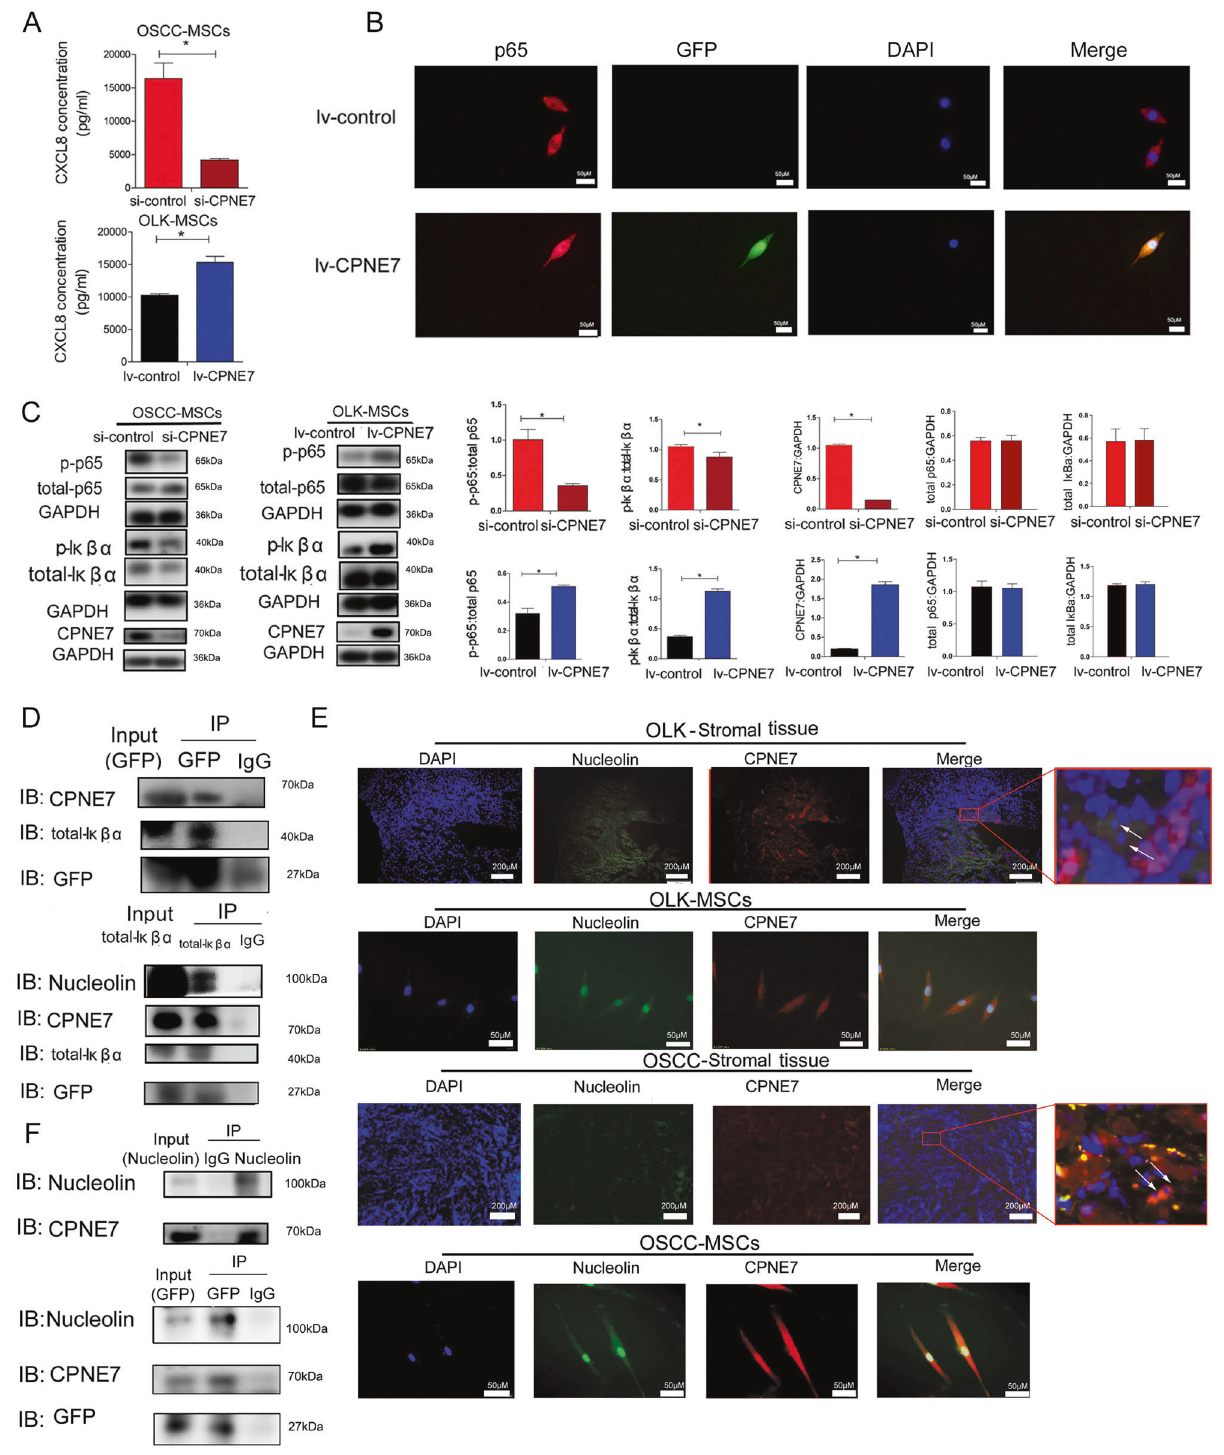
Fig. 6 CPNE7 could enhance the secretion of CXCL8 and interact with I κ ß α through the NF- κ B pathway. A Overexpression and knockdown of CPNE7 in MSCs regulated CXCL8 secretion. B Immuno fl uorescence on overexpression of CPNE7 (GFP-tagged CPNE7) in OSCC-MSCs was performed to detect the localization of p65 (red) and GFP (green) were stained with DAPI (blue). C Western blot was used to measure the difference in the expression of p65 and I κ B α (NF- κ B pathway) in CPNE7-overexpressing OLK-MSCs and CPNE7-knockdown OSCC-MSCs. D Immunoprecipitated (IP) CPNE7 and whole-cell lysates (Input) were analysed by immunoblotting (IB) with anti- I κ B α , Nucleolin, CPNE7, and GFP antibodies. E Co-localization of CPNE7 and Nucleolin in tissue and MSCs. The arrow indicated the co-expression of CPNE and Nucleolin in the same cells of the tissue. F Immunoprecipitated (IP) CPNE7 and whole-cell lysates (Input) were analysed by immunoblotting (IB) with anti- CPNE7, Nucleolin, and GFP antibodies. The tests were repeated three times. Data were expressed as means ± SD. * p < 0.05.